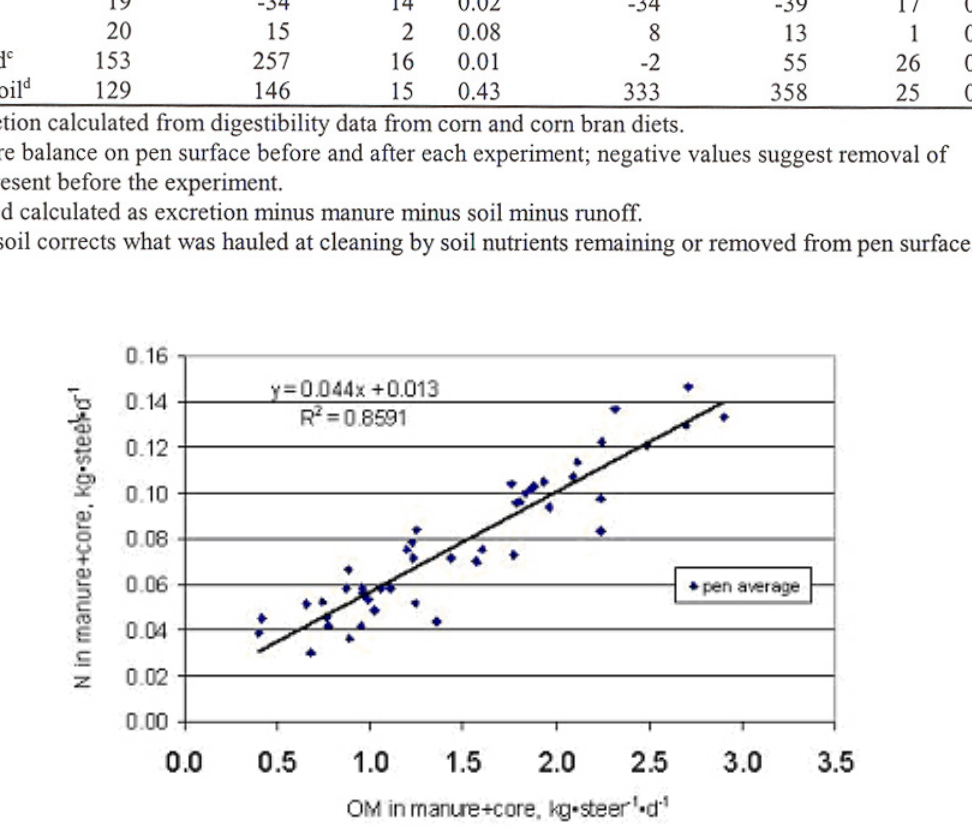
FIGURE 2 . Regression of manure OM and manure N adjusted for soil for all four experiments where each dot represents a pen (48). N excretion varied from 0.15 to 0.22 kg per steer per